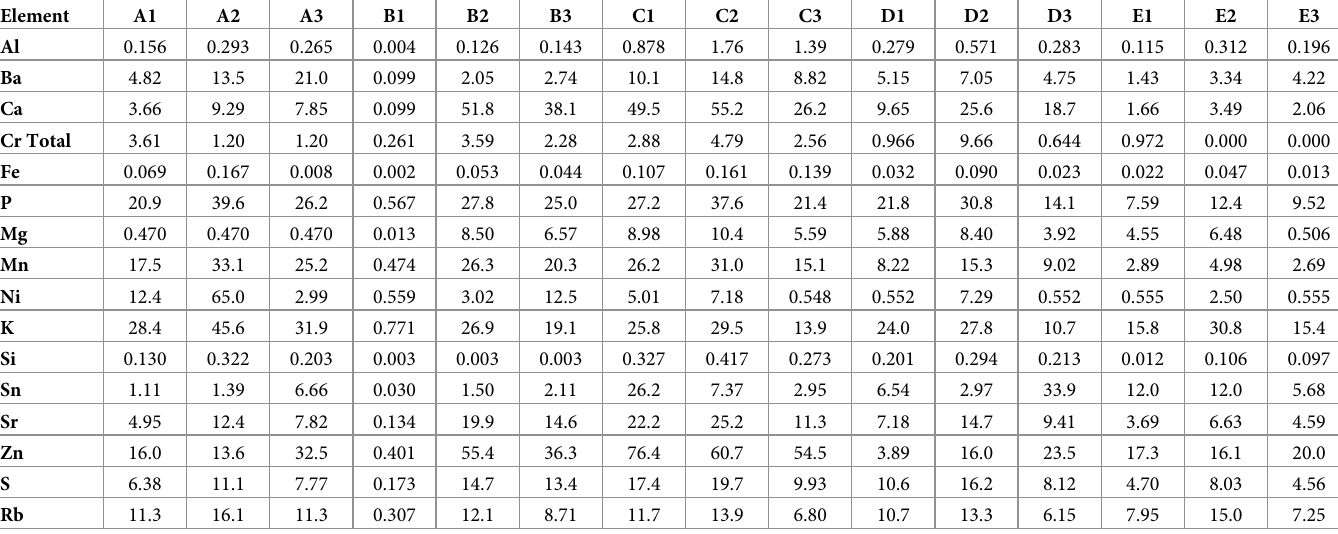
Table 3. Element % extraction (mean of three analyses) in three fractions (1, 2 and 3) of five different leachants in the batch extraction test (A = 0,4 M MgCl 2 ; B =